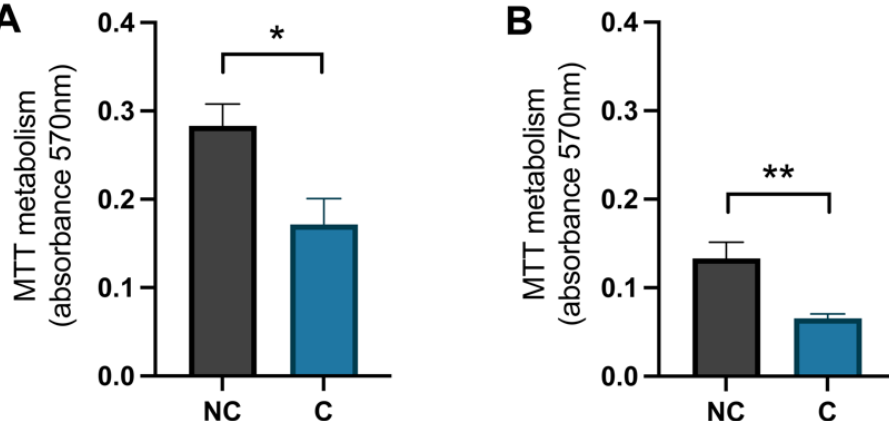
Figure 5. The effect of hydrogen peroxide on mitochondrial activity. The levels of metabolised MTT for ( A ) hippocampal cells and ( B ) cortical cells, negative control (NC) cells compared to positive control (C) cells. NC was treated with MQH 2 O from days 8–10 and C with hydrogen peroxide from days 8–9 and 0.1% DMSO from days 9–10. There was a significant decrease in mitochondrial activity in the control cells compared to the negative control cells in both hippocampal and cortical cultures ( n = 5). All data are presented as means ± SEM, * p -value < 0.05, ** p -value < 0.01.